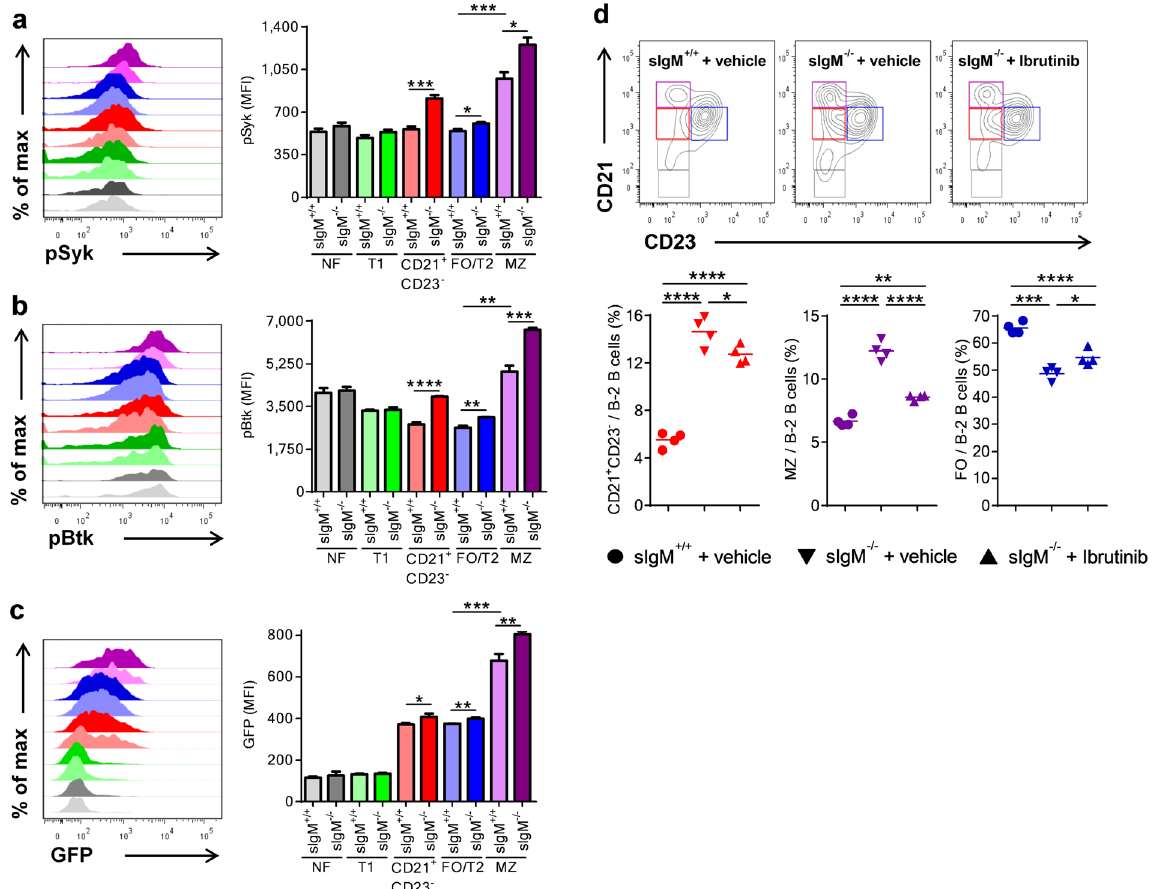
Figure 2. sIgM deficiency results in increased B cell receptor signaling in vivo . Representative flow cytometry plots and bar graphs show ( a – c ) the mean fluorescence intensity (MFI) for pSyk, pBtk levels and Nurr77-GFP expression in FO/T2 (blue), MZ (purple), CD21 + CD23 − (red), T1 (green) and NF (grey) B cells (as defined in Fig. S2) of sIgM + / + or Nur77-GFP / sIgM + / + (light colored bar) and sIgM − / − or Nur77-GFP / sIgM − / − (dark colored bar) mice. Data shown are from one representative experiment ( a , b ) or pooled ( c ) from two/three independent experiments. ( d ) Representative flow cytometry plots and dot plots show the frequencies of CD21 + CD23 − (red), FO (blue) and MZ (purple) B cells within B-2 cells of sIgM + / + ( ● ) and sIgM − / − ( ▼ ) mice treated with vehicle, and sIgM − / − ( ▲ ) mice treated with the Btk inhibitor Ibrutinib. All results show mean ± SEM, n = 4–6 mice per group. * P < 0.05, ** P < 0.01, *** P < 0.001, **** P < 0.0001 (unpaired or paired t test or One-Way Anova test followed by Tukey’s